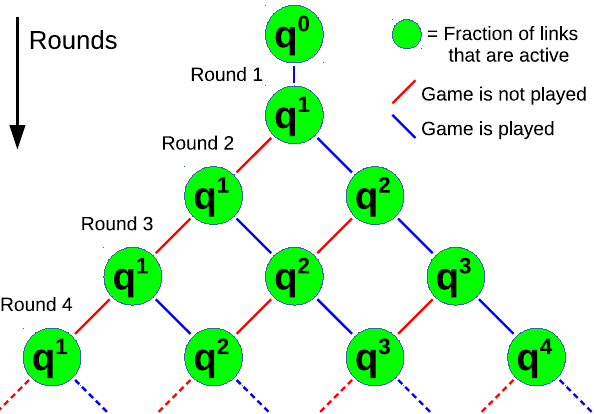
Figure 2. Schematic showing how the fraction of active links between the defector and cooperators decreases as additional exploitations occur. At the start of a generation, all links to cooperators are active. On the first round, the defector plays a game, and a fraction q of the links remain active after the game. On each round thereafter, the defector plays another game with probability q i , where i is the number of games that have been played to that